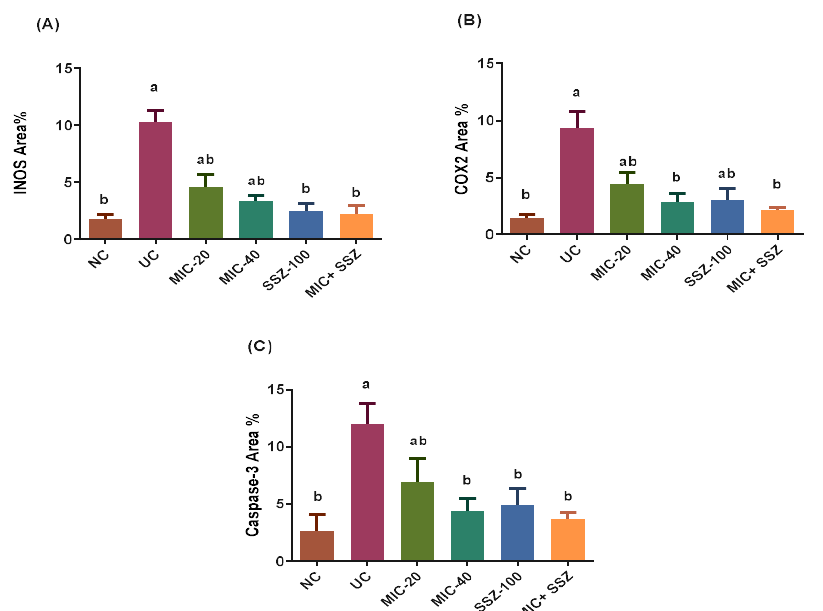
Figure 8. Effect of miconazole, sulfasalazine and their combination on INOS, COX2 and Caspase-3 in AA-induced UC. ( A ) INOS positively stained area percentage. ( B ) COX2 positively stained area percentage. ( C ) Caspase-3 positively stained area percentage. Each group’s values are expressed as the mean ± SEM of seven animals. a Significantly different at p ≤ 0.05 from the negative control (NC) values. b Significantly different at p ≤ 0.05 from the ulcerative colitis control (UC) values.